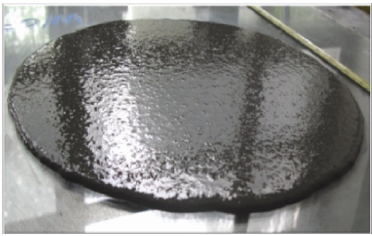
Fig. 4. The segregation-free highly fluid mortar incorporating an AFA